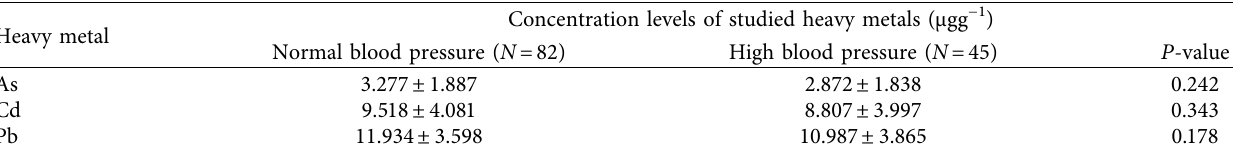
Table 11: Concentration levels of As, Cd, and Pb in farmers’ fingernail samples according to their blood pressure. Heavy